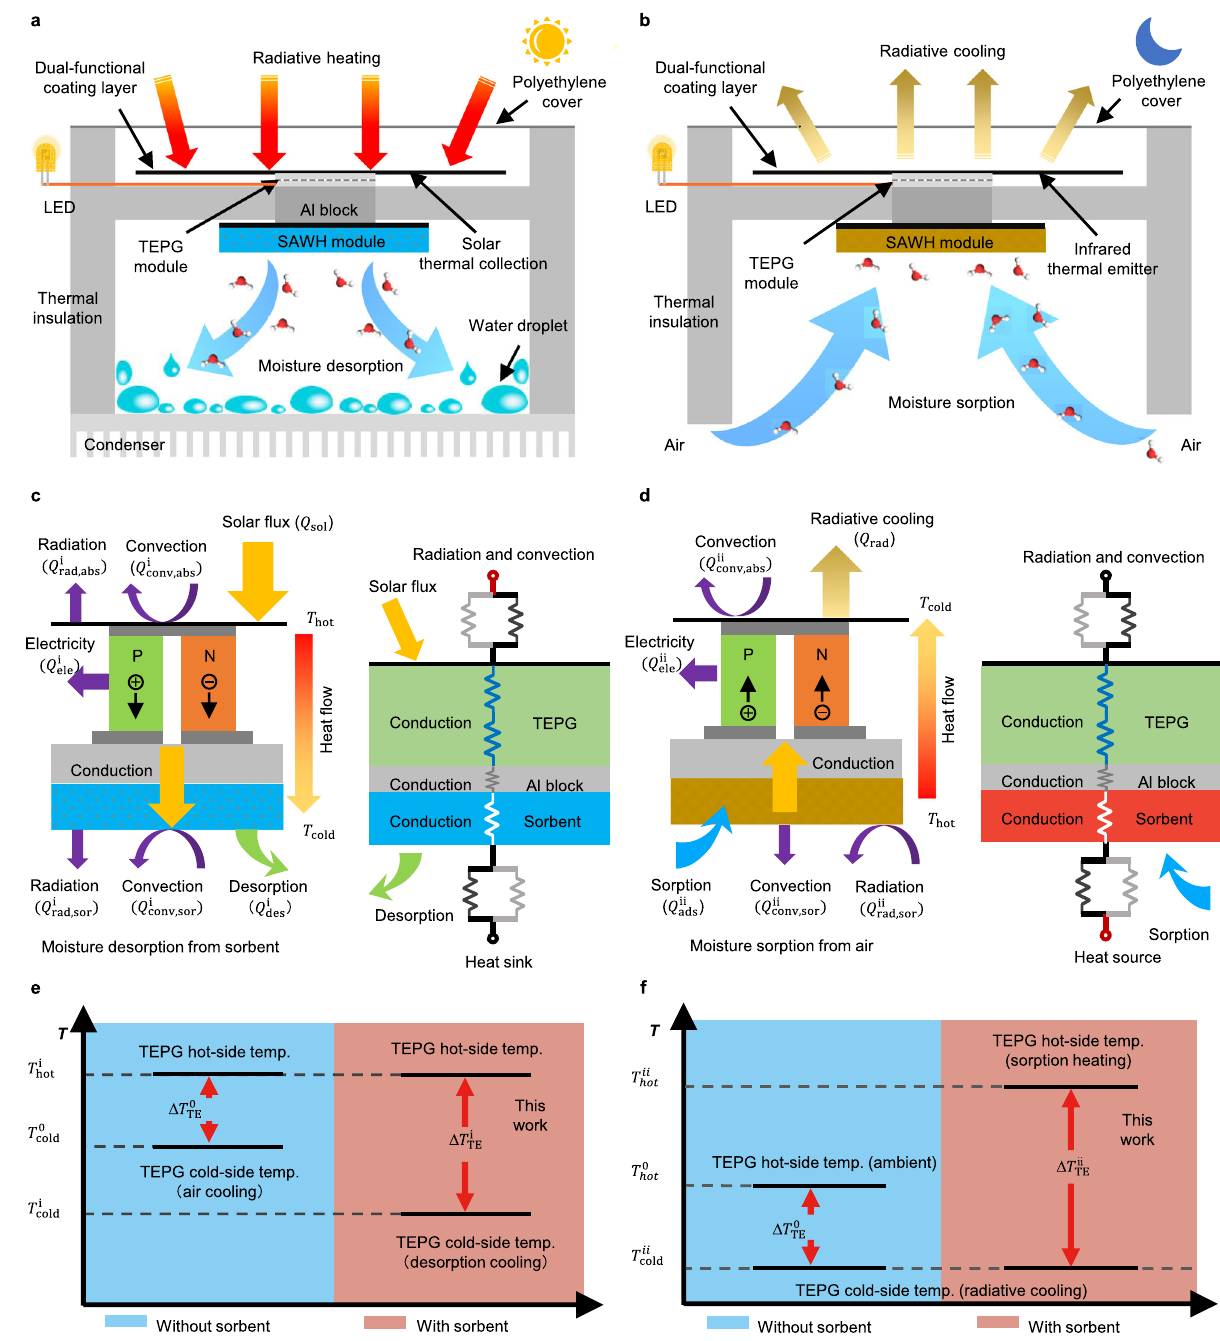
Fig.1|Synergisticeffectsofmoisture-inducedenergyharvestingforwaterand power co-generation. a Schematic of water production and power generation by radiativeheatingfromsunlightduringdaytime. b Schematicofwatervaporcapture from air and power generation by radiative cooling from the universe during nighttime. c Energy balance and thermal network of hybrid SAWH-TEPG by radia- tive heating during daytime. d Energy balance and thermal network of hybrid